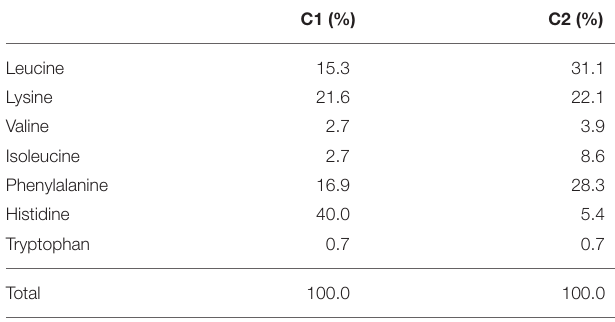
TABLE 1 | Composition of amino acids